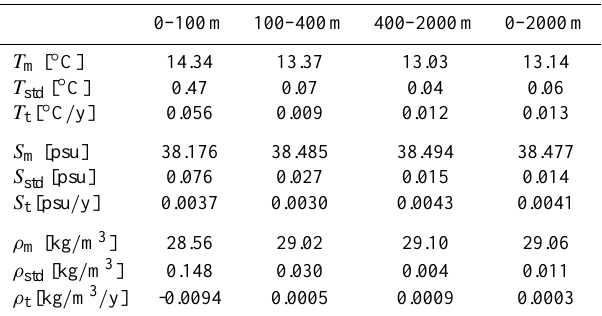
Fig. 4. Temperature ( ◦ C) from Dyfamed for the 0–100m (top), the 100–400m (middle), the 400–2000m (bottom, green) and the 0–2000m (bottom, black) layers. For each plot, the corresponding thick line joins the interpolated values for the 1 December of each year between 1995 and 2004.